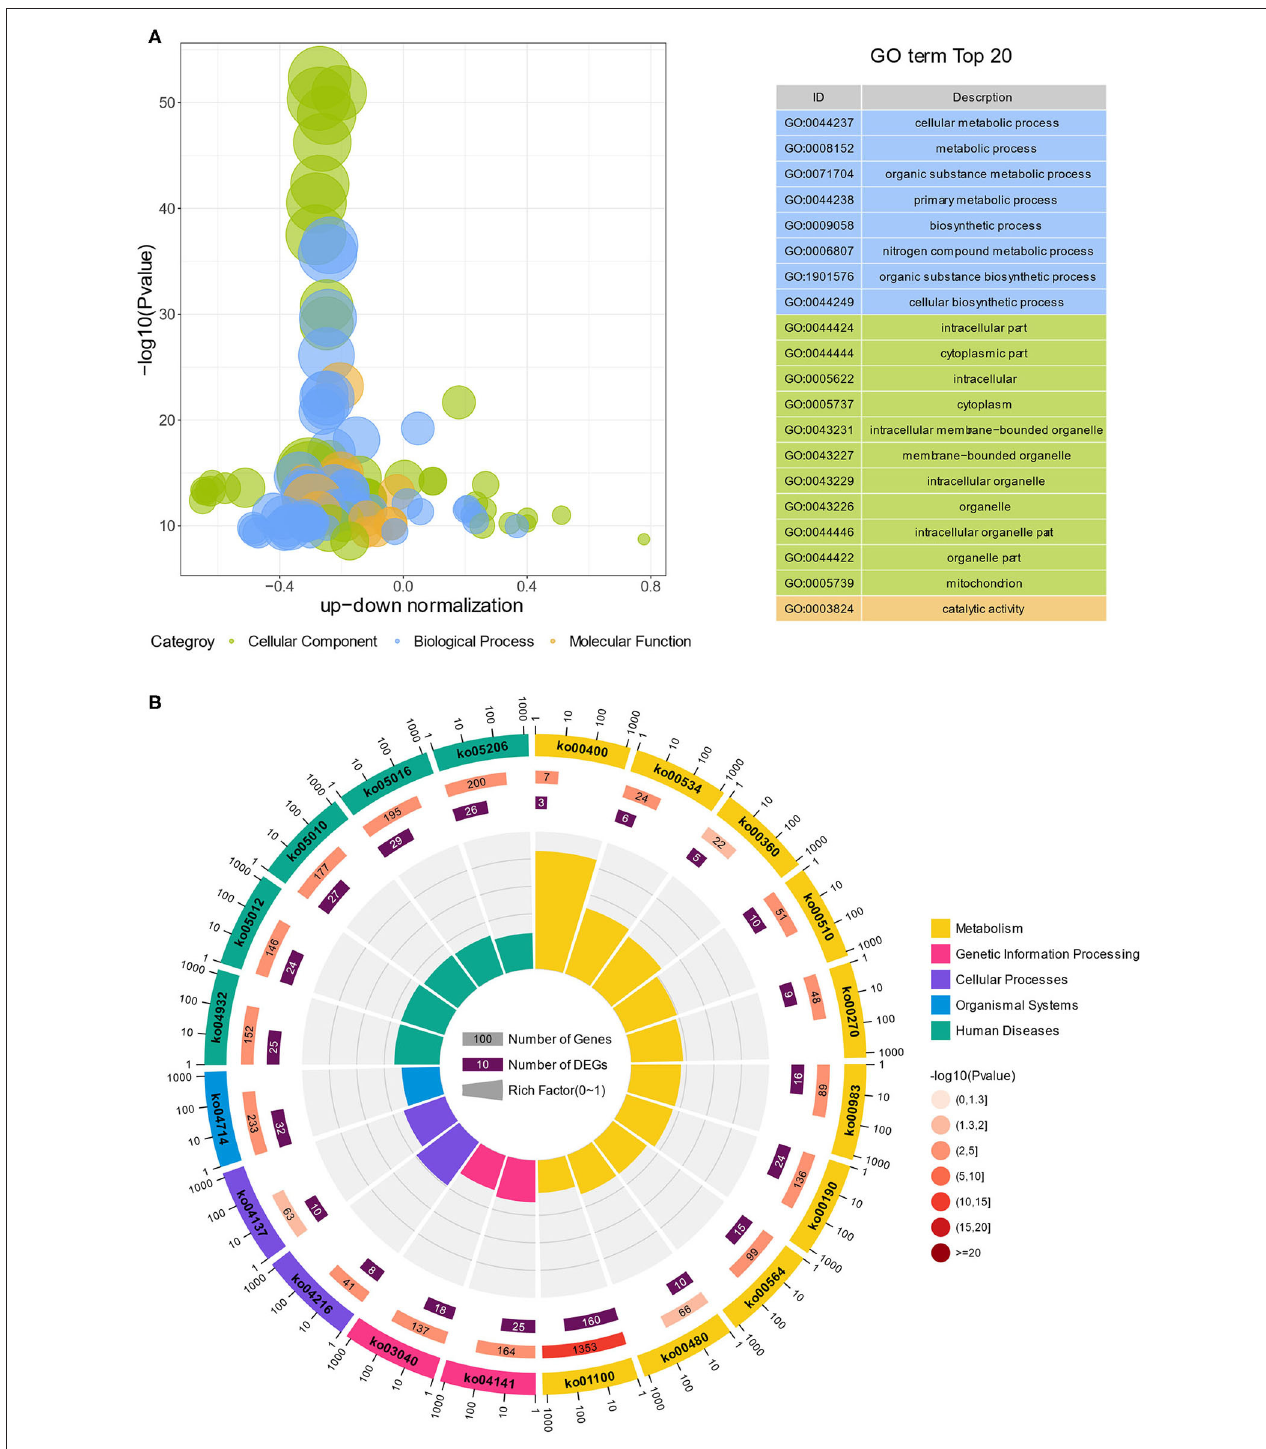
FIGURE 4 | GO and KEGG analysis of DEGs in Ribo-seq. (A) GO bubble diagram showing the top 20 enriched GO terms. Three colors represent three GO categories, including cellular component, biological process and molecular function. (B) The enrichment circle diagram shows the KEGG analysis of the top 20 pathways. Four circles from the outside to the inside. First circle: the classification of enrichment, outside the circle is the scale of the number of genes. Different colors represent different categories. Second circle: number and p -values of the classification in the background genes. The more genes, the longer the bars, the smaller the value, the redder the color. Third circle: bar chart of the total number of DEGs. Fourth circle: rich factor value of each classification (number of DEGs in this classification divided by the number of background genes). Each cell of the background helper line represents 0.1.